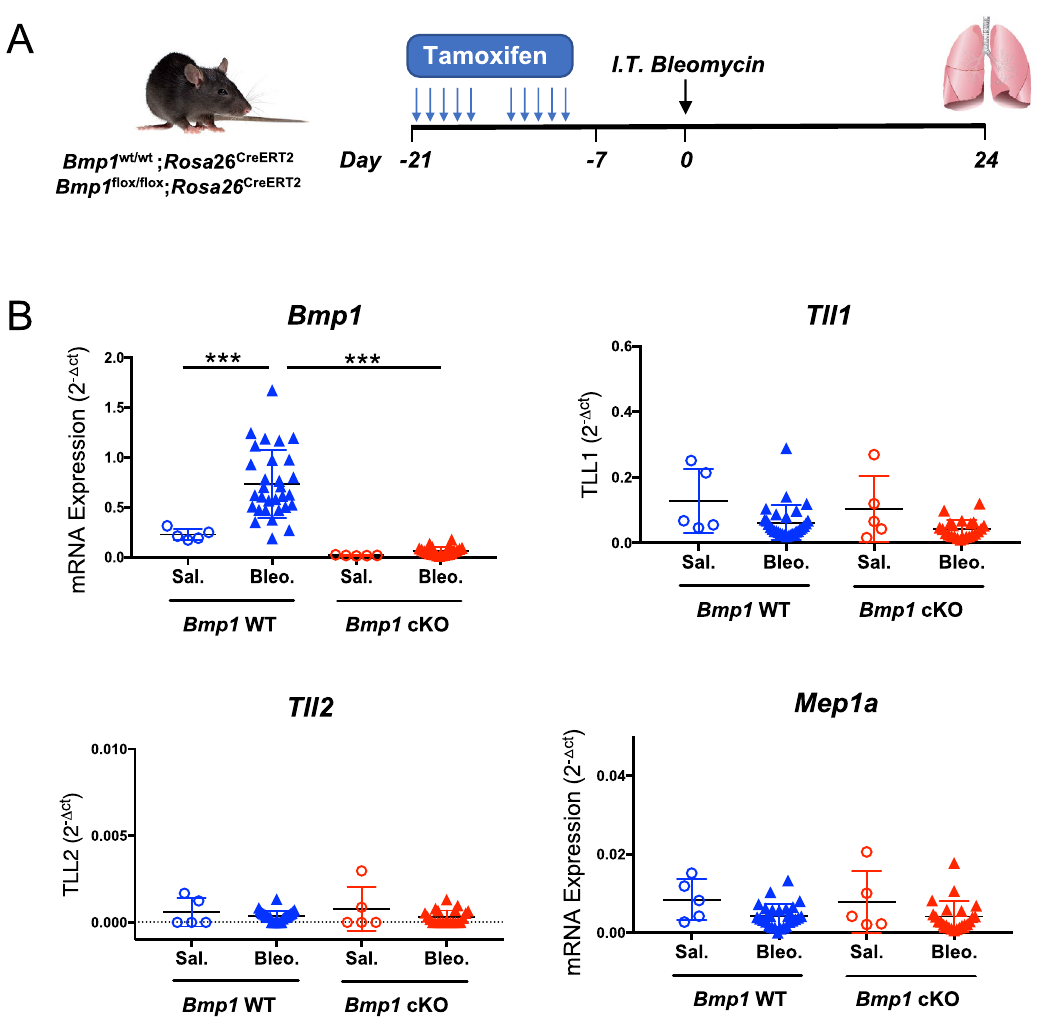
Figure 3. Inducible and efficient deletion of Bmp1 in the bleomycin model. ( A ) Schematic regime of tamoxifen- induced Bmp1 deletion following by intratracheal bleomycin challenge. Tissue harvesting on day 24 after bleomycin challenge. ( B ) mRNA expression of Bmp1 , Tll1 , Tll2 and Mep1a . Bmp1 WT: Saline n = 5, bleomycin n = 30; Bmp1 cKO: saline n = 5, bleomycin n = 21. ***p < 0.001. Data represents mean ± SD. p-value is calculated using one-way